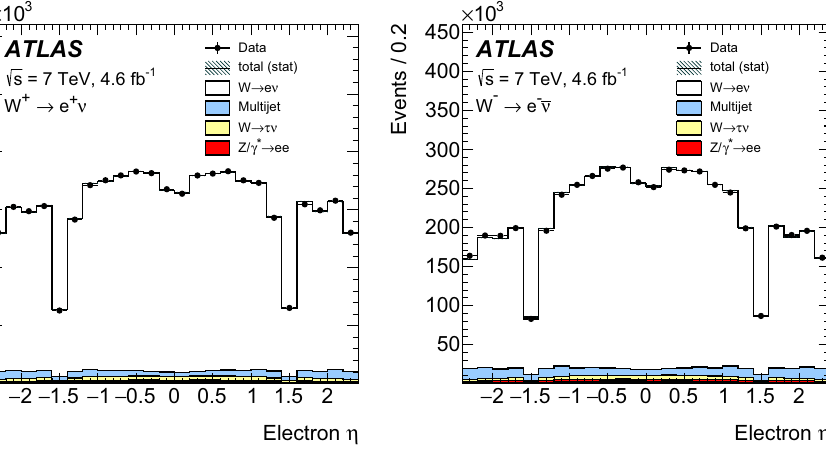
Fig. 4 The pseudorapidity distribution of electrons for W + → e + ν candidates ( left ) and W − → e − ¯ ν candidates ( right ). The simulated samples are normalized to the data luminosity. The multijet background shape is taken from a data control sample and normalized to the esti-